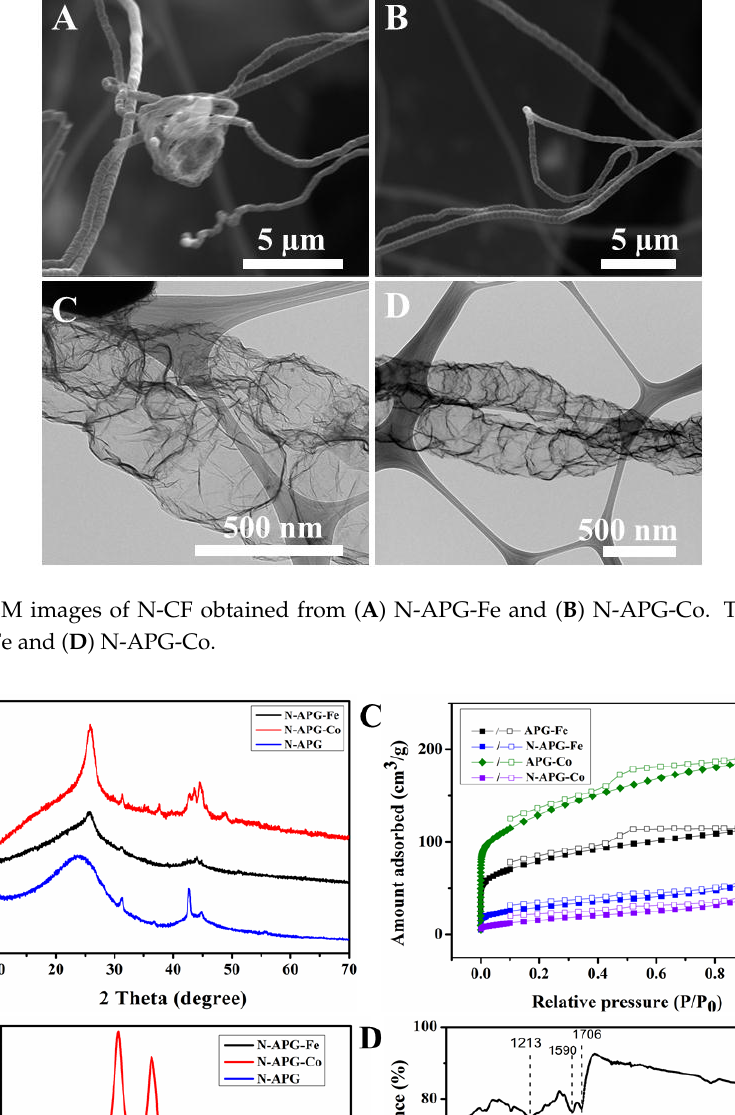
Table 1. Surface area of doped and non-doped apricot catalysts with Fe and Co. Catalyst